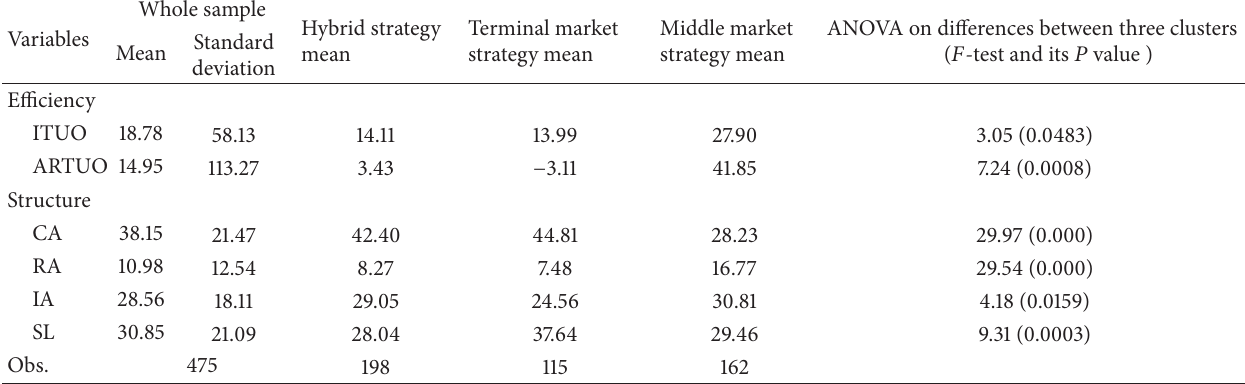
Table 4: Working capital allocation for the whole sample and comparison across the three strategies.